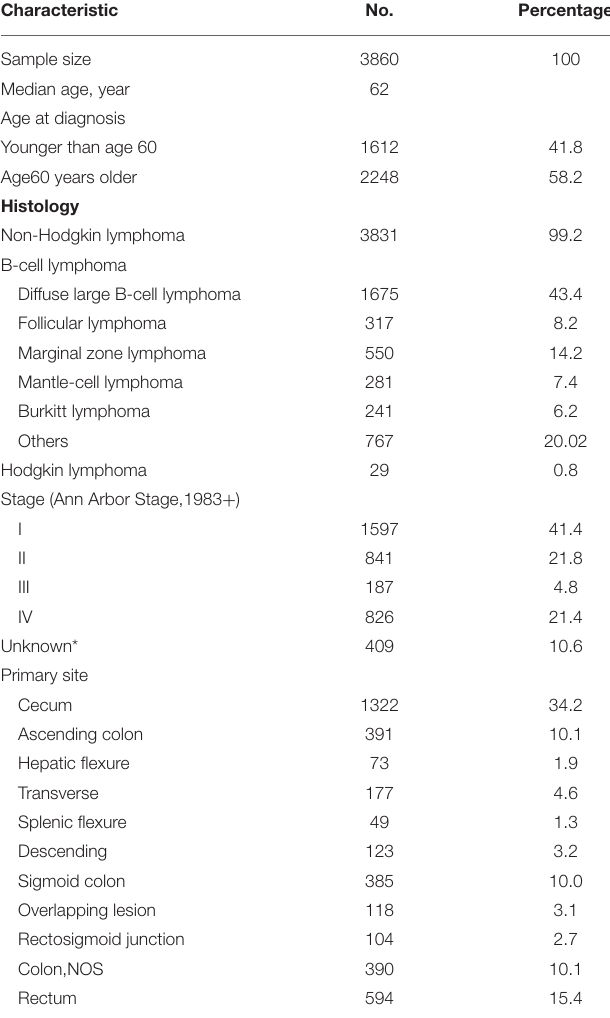
TABLE 1 | Patient and tumor characteristics of primary colorectal lymphoma diagnosed in SEER 18 registries, 1973–2012.